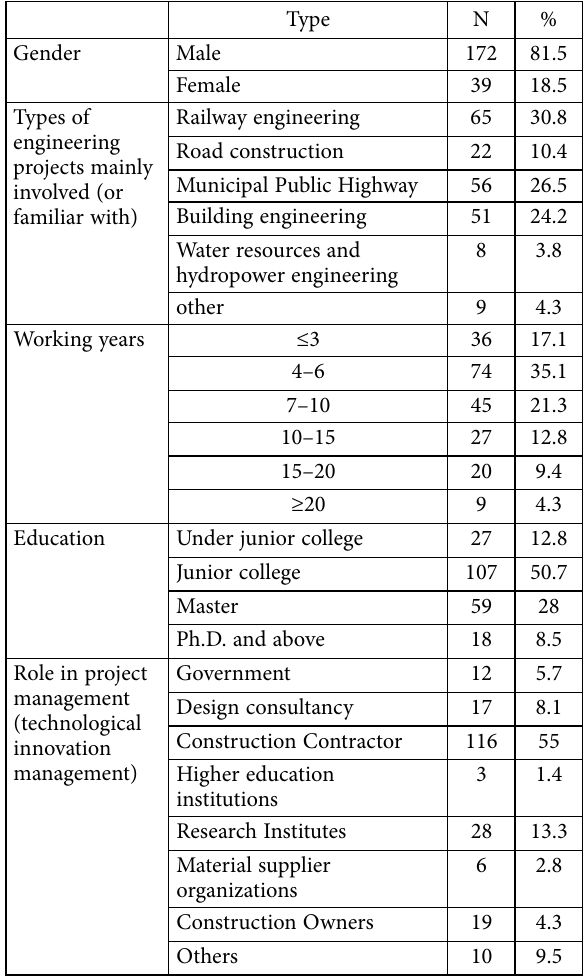
Table 1. Characteristics of the